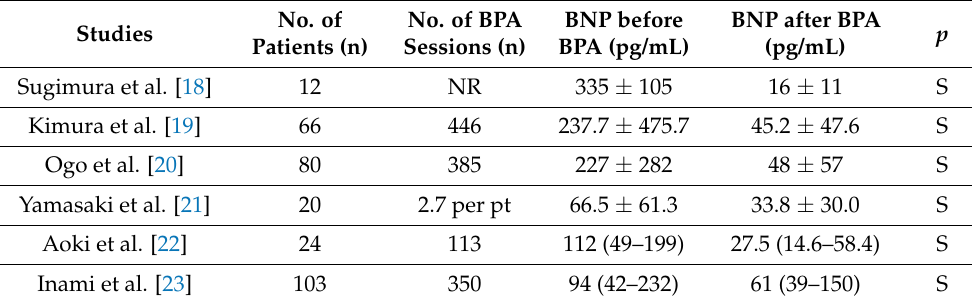
Table 1. Changes in BNP levels in CTEPH patients before and after BPA treatment in the hitherto published case series.